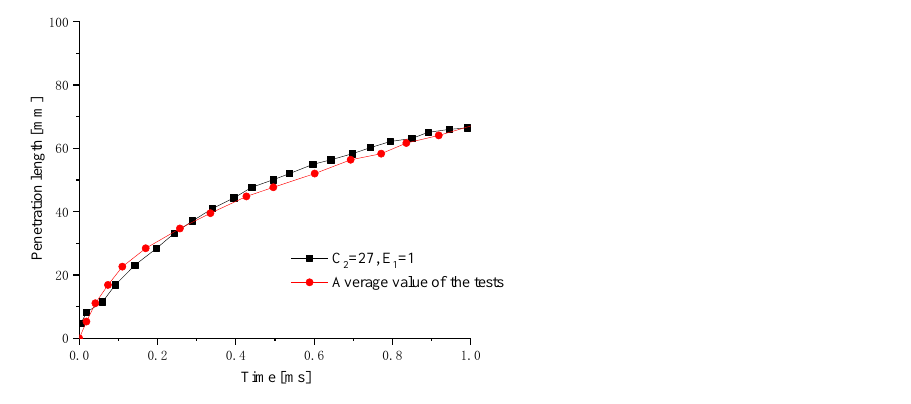
Figure 5. Comparison of the liquid penetration length between the simulated and experimental re- sults for Case 1.